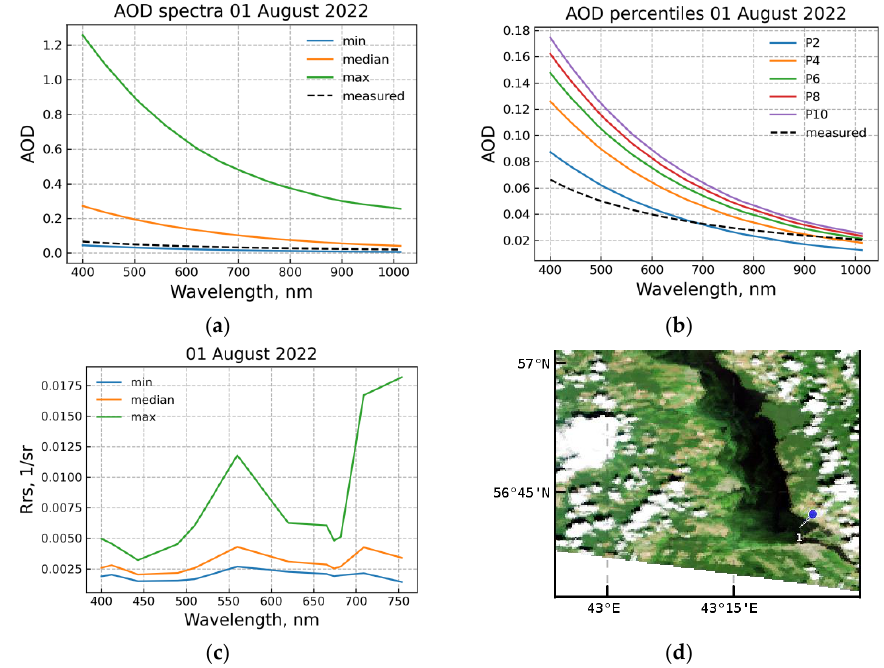
Figure 7. AOD and R rs spectra retrieved from the Sentinel-3A/OLCI image for 1 August 2022: ( a ) AOD spectra in the test region according to AC ac-2 (the minimum AOD spectrum is shown by the blue line, the median by the orange line, and the maximum by the green line) and measured AOD (black dotted line); ( b ) AOD percentiles in the test area according to AC ac-2 (P2, P4, P6, P8, and P10 are the second, fourth, sixth, eighth, and tenth percentiles, respectively) and measured AOD (dashed black line); ( c ) R rs spectra in the test area according to AC with fixed AOD based on the second percentile P2 (the minimum R rs spectrum is shown by the blue line, the median by the orange line, and the maximum by the green line); ( d ) Sentinel-3A/OLCI RGB composite for 1 August 2022.